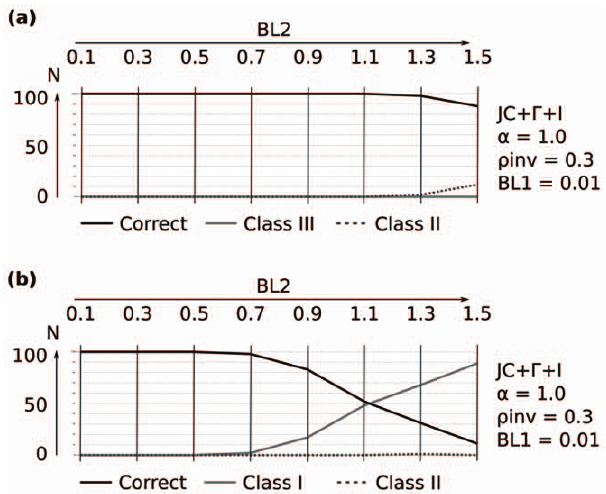
Figure 5. Reconstruction success of ML (100,000 base posi- tions). a) Topology A (Figure 2a) and b) Topology B (Figure 2b) under alignment lengths of 100,000 base positions if model assumptions are identical to the simulated parameters ( a ~ 1 : 0 ; r inv ~ 0 : 3 ). Branch length differences increase from left to right by increasing BL 2 in discrete steps (0.1–1.5) while BL 1 is kept constant (0.01). The y-axis depicts the reconstruction success of the 100 simulation repeats (N).